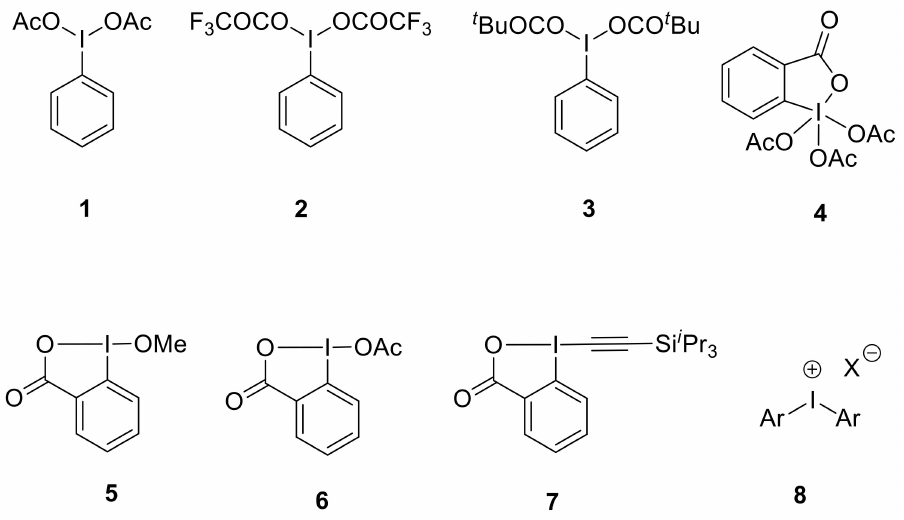
Figure 1. Examples of hypervalent iodine(III)/(V) reagents 1–8